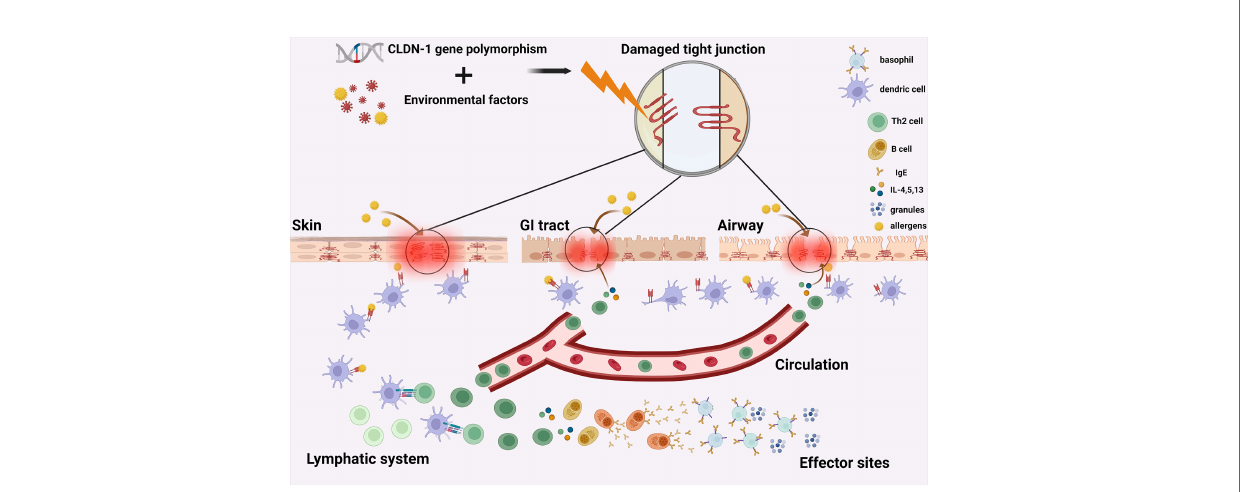
FIGURE 1 | Claudin-1-mediated tight junction dysfunction contributes to the atopic march. The synergic effect of CLDN-1 gene polymorphism and environmental factors lead to common disturbance of claudin-1 in the epithelium of skin, airways and GI tract, causing tight junction dysfunction and impaired epithelial barrier function in these organs. Entry of allergens through damaged skin barrier leads to the systemic type 2 in fl ammation in patients with AD, which further downregulates the claudin-1 expression level in the GI tract and airways. This exacerbation of barrier impairment in the intestinal and airway epithelium fi nally leads to the progression of allergic in fl ammation from skin to the GI tract and then to airways. GI, gastrointestinal; Th2 cell, Type 2 helper T cell; B cell, B lymphocyte; IgE, immunoglobulin E; IL-4, interleukin 4; IL-5, interleukin-5; IL-13, interleukin-13. Granules, granules secreted by basophils containing mediators of in fl